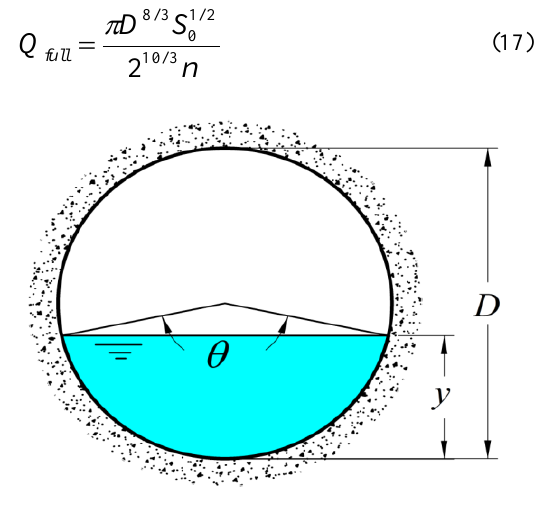
Fig. 1. Cross section of a partially filled circular